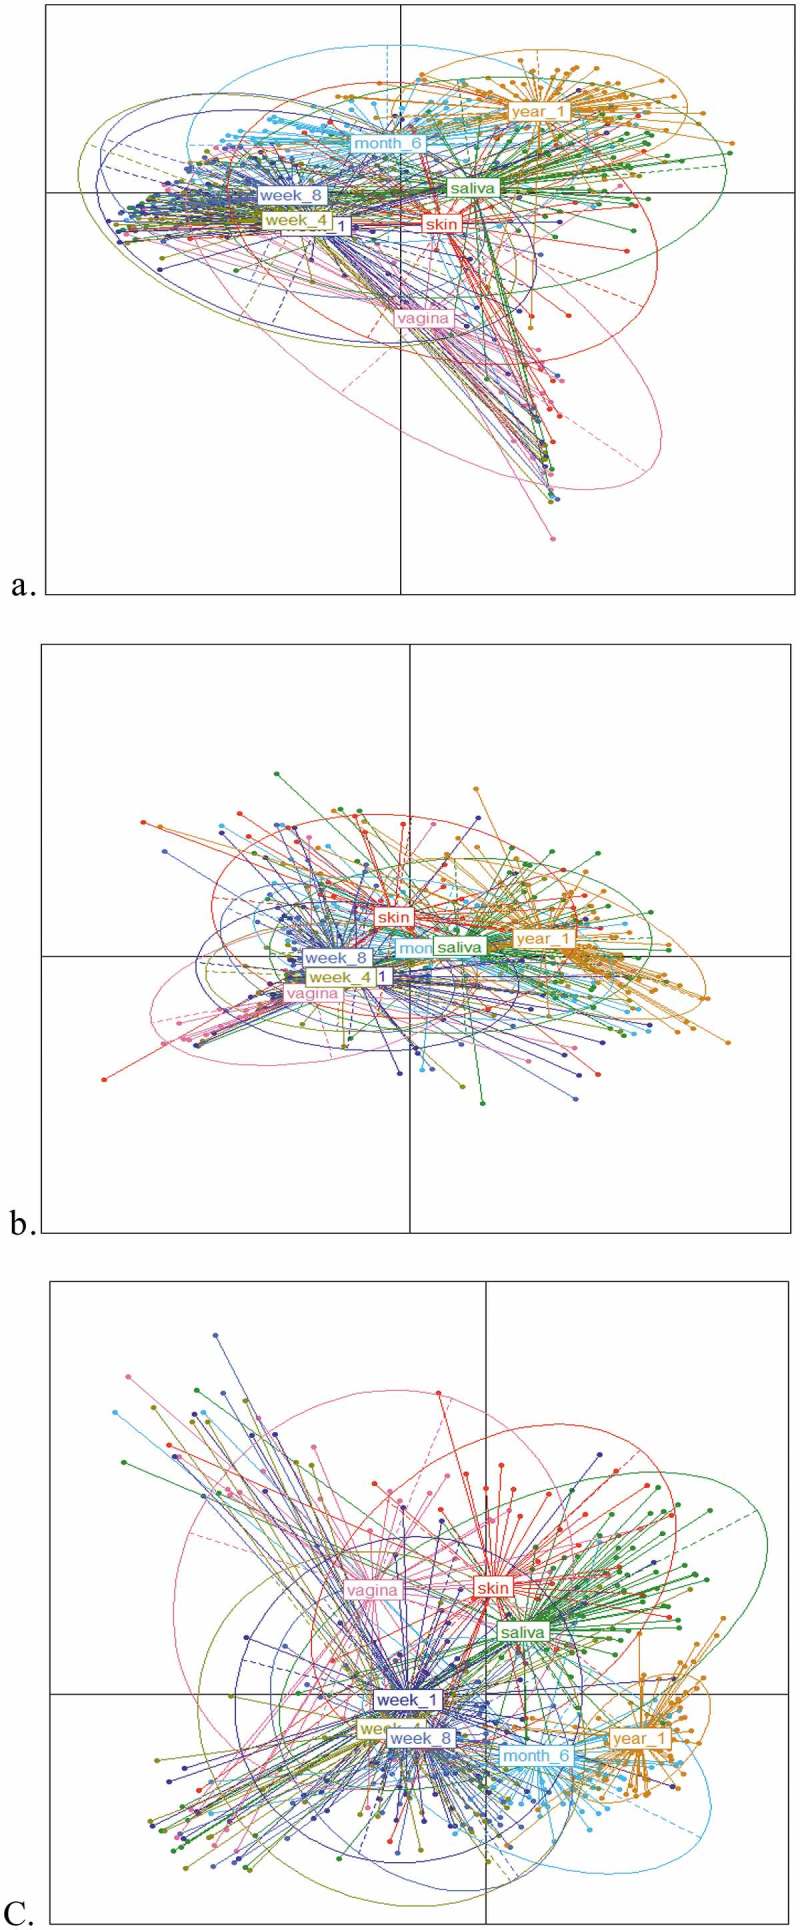
Principle coordinates analyses (PCoAs) on Spearman distance matrices of samples from mother (saliva, skin and vagina) and from infant oral cavity at 5 time points (weeks 1, 4, 8, 6 months and 1 year). (a) Bray–Curtis dissimilarity, (b) UniFrac weighted, and (c) unweighted UniFrac between the 8 groups (mother saliva/oral cavity, skin and vaginal and infant oral cavity at weeks 1, 4, 8, 6 months and 1 year). (a) Plot of principle coordinates using Bray–Curtis dissimilarity. Points are coloured according to group and ellipses describe the distribution of points for each group. Percentage variation explained: PCA 1 (18.5%) and PCA 2 (9.2%). (b) Plot of principle coordinates using weighted UniFrac distance. Points are coloured according to group and ellipses describe the distribution of points for each group. Percentage variation explained: PCA 1 (39.2%) and PCA 2 (11%). (c) Plot of principle coordinates using unweighted UniFrac distance. Points are coloured according to group and ellipses describe the distribution of points for each group. Percentage variation explained: PCA 1 (18.4%) and PCA 2 (6.7%).